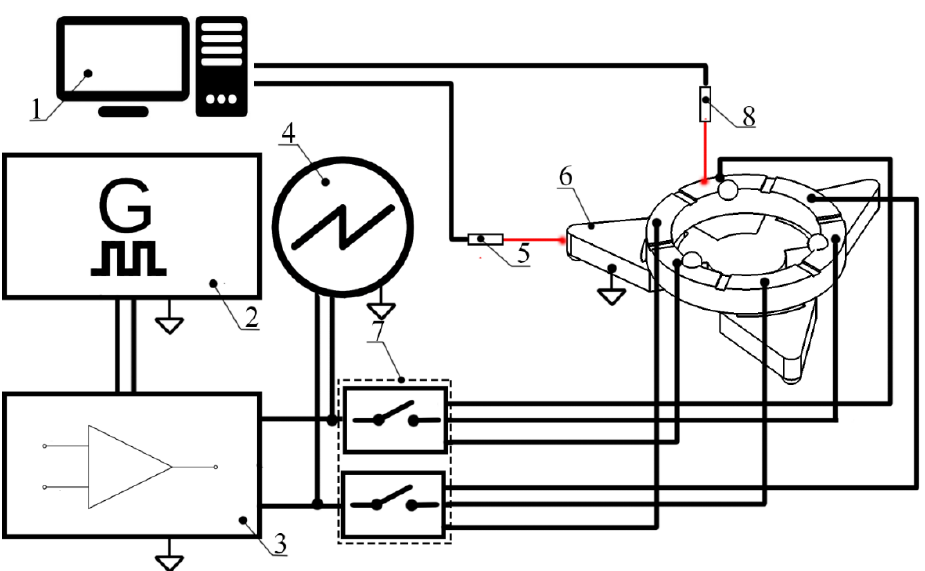
Figure 15. Schematics of the experimental setup; 1—computer; 2—signal generator with two independent channels; 3—power amplifier; 4—oscilloscope; 5—laser displacement sensor for planar motion measurements; 6—the prototype of the robot; 7—two-channel switch box; 8—tachometer for measurements of angular motion.